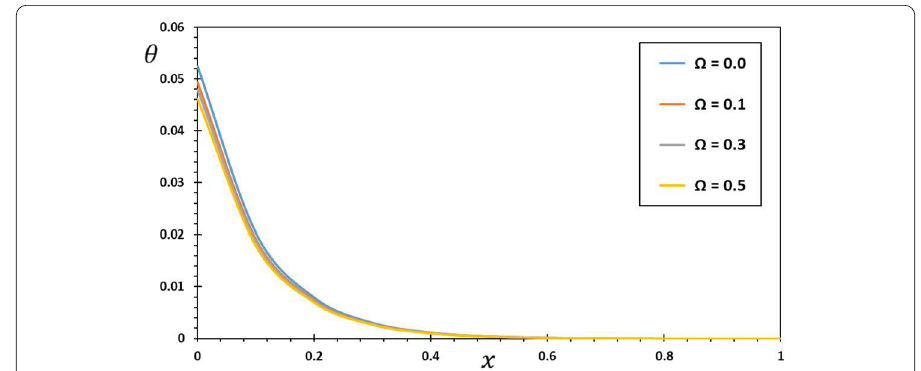
Figure 3 The effect of rotation ( (cid:5) ) on the variation of temperature θ